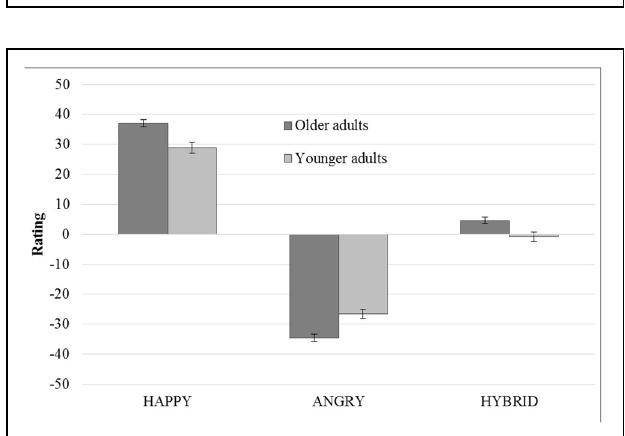
FIGURE 3 | Facial expressions ratings.